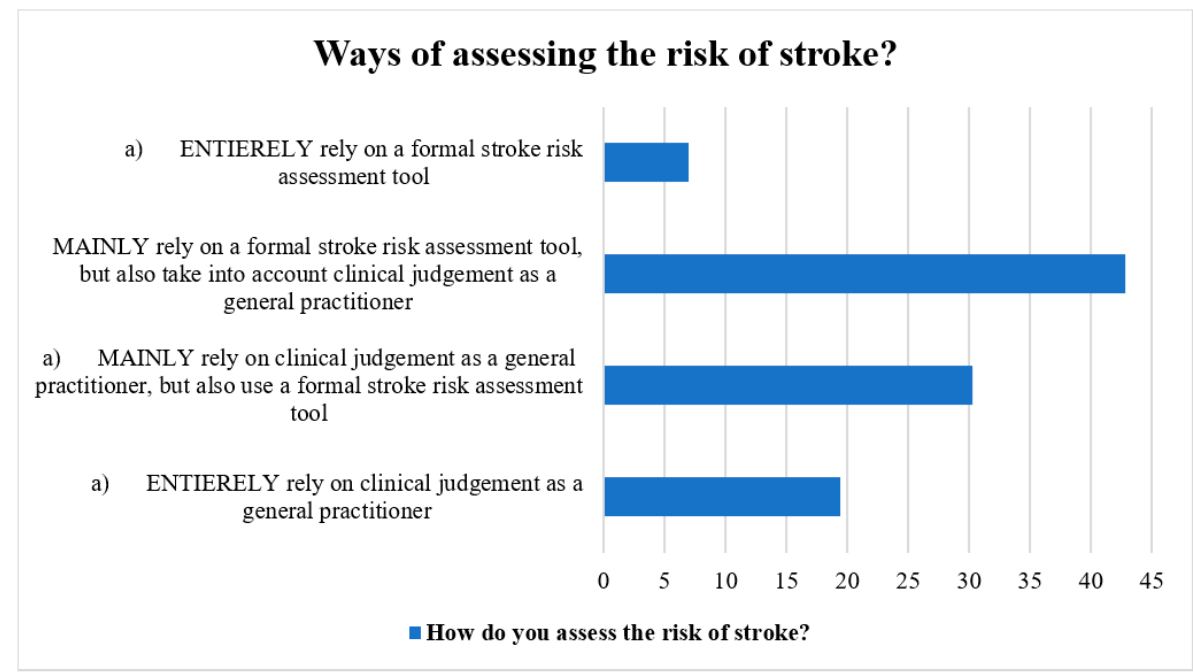
Figure 1. Ways of assessing stroke risk by the participants.